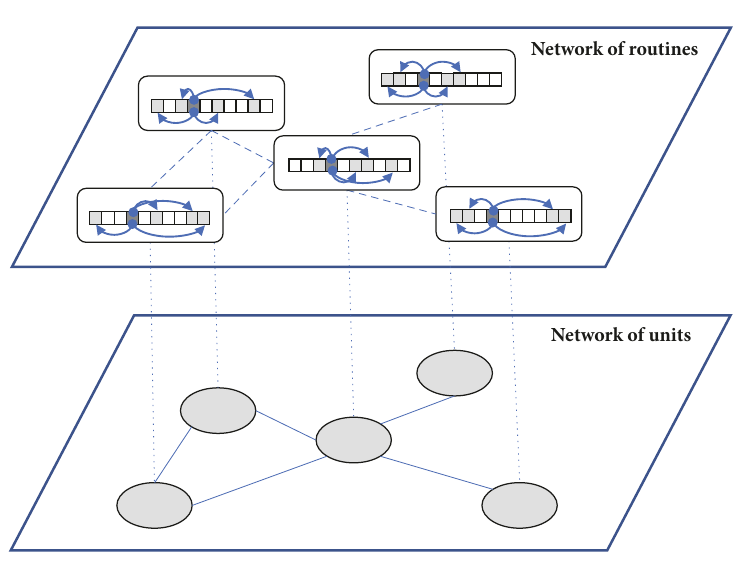
Figure 2: Network of units with different routine